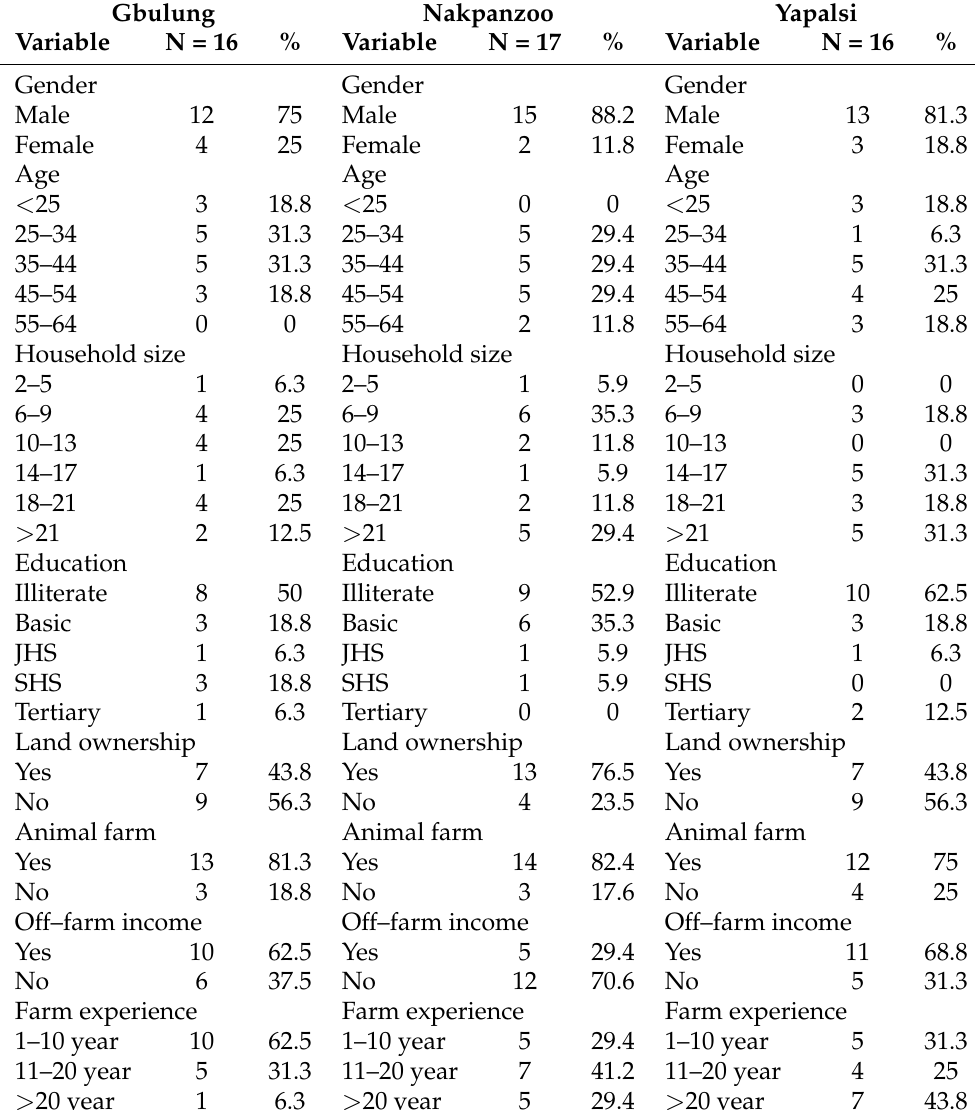
Table 1. Characteristics of the